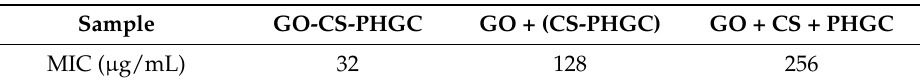
Table 1. MIC values of GO-CS-PHGC, the mixture of GO, CS and PHGC (GO + CS + PHGC) and